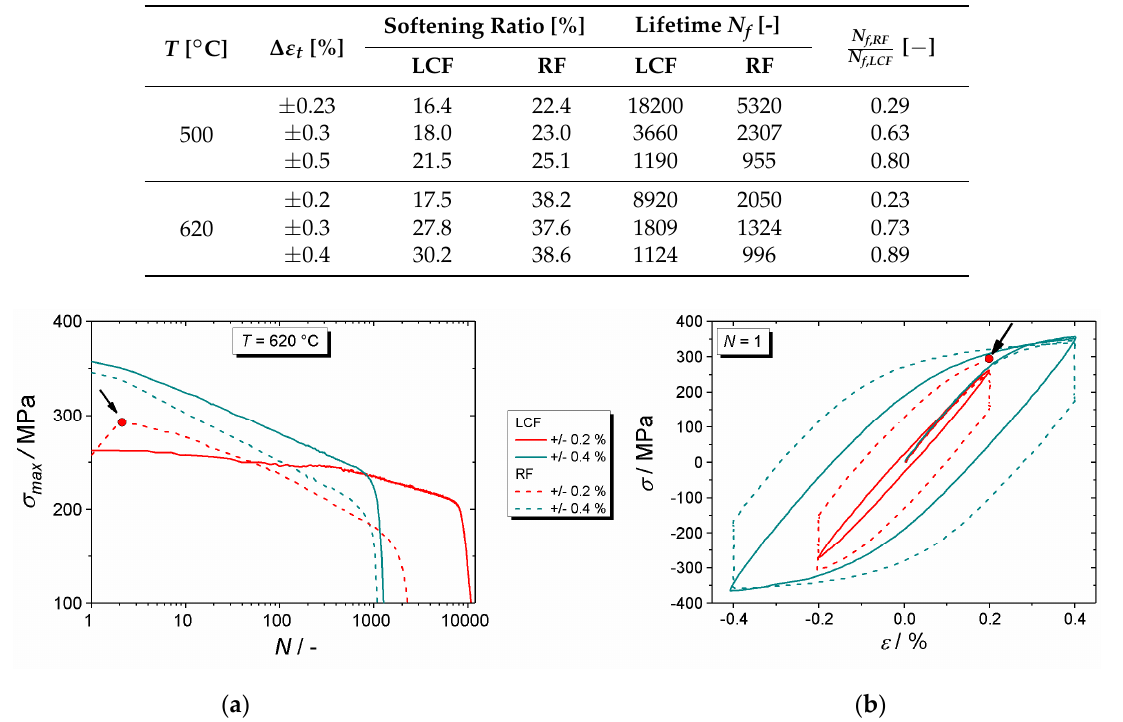
Figure 13. Cyclic softening curves ( a ) and hysteresis loops of the first cycle ( b ) for selected LCF- and RF-tests at 620 °C. Table 8. Softening ratio, lifetime, and lifetime ratio for different LCF- and RF-tests.